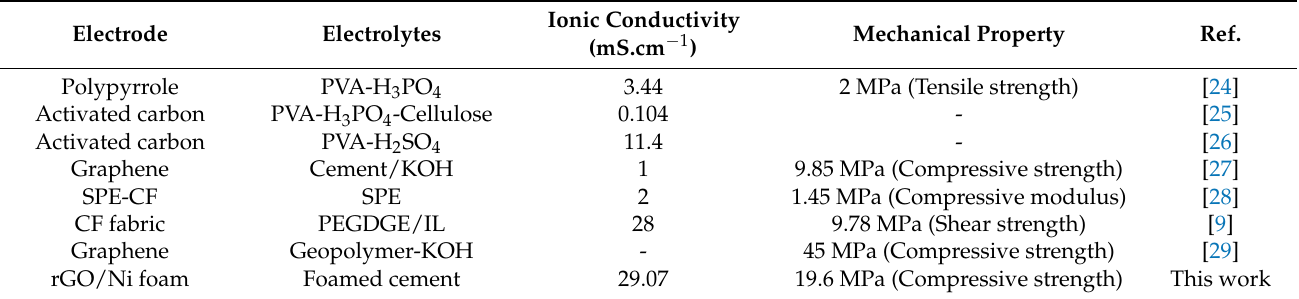
Figure 4. ( a ) Ionic conductivity; ( b ) compressive strength; and ( c ) multifunctional performance of different foamed porous cement specimens. Table 3. The ionic conductivity comparation of our device assembles by PC0.6 electrolyte with other solid devices.